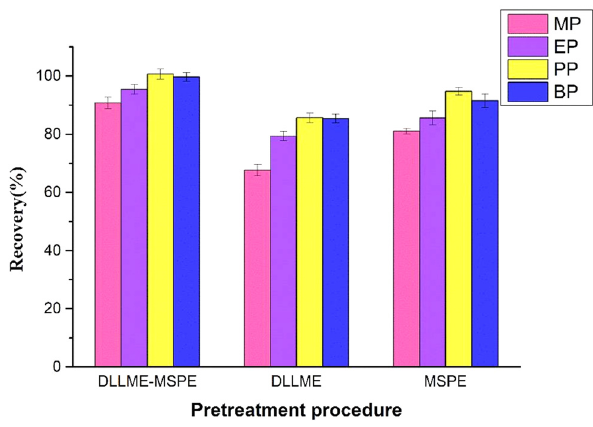
Figure 9: Comparison of pretreatment methods between DLLME - MSPE, DLLME, and